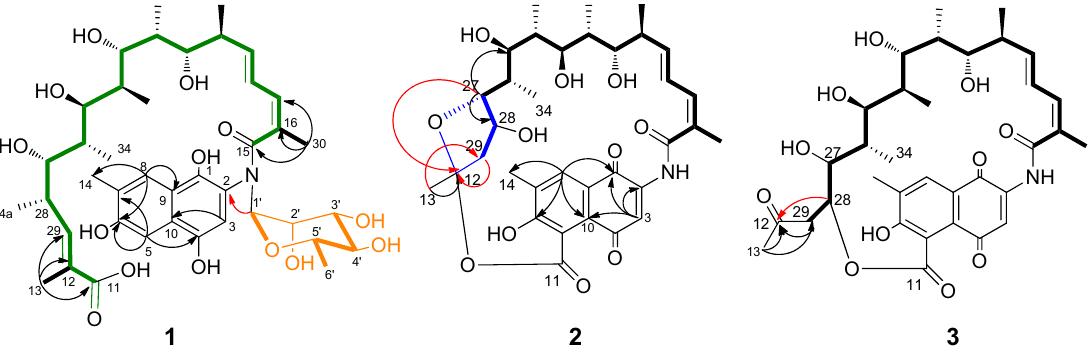
Figure 3. Selected HMBC ( 1 H detected heteronuclear multiple bond correlation) ( → ) and 1 H- 1 H COSY (correlation spectroscopy) ( — ) correlations of compounds 1 , 2 and 3.